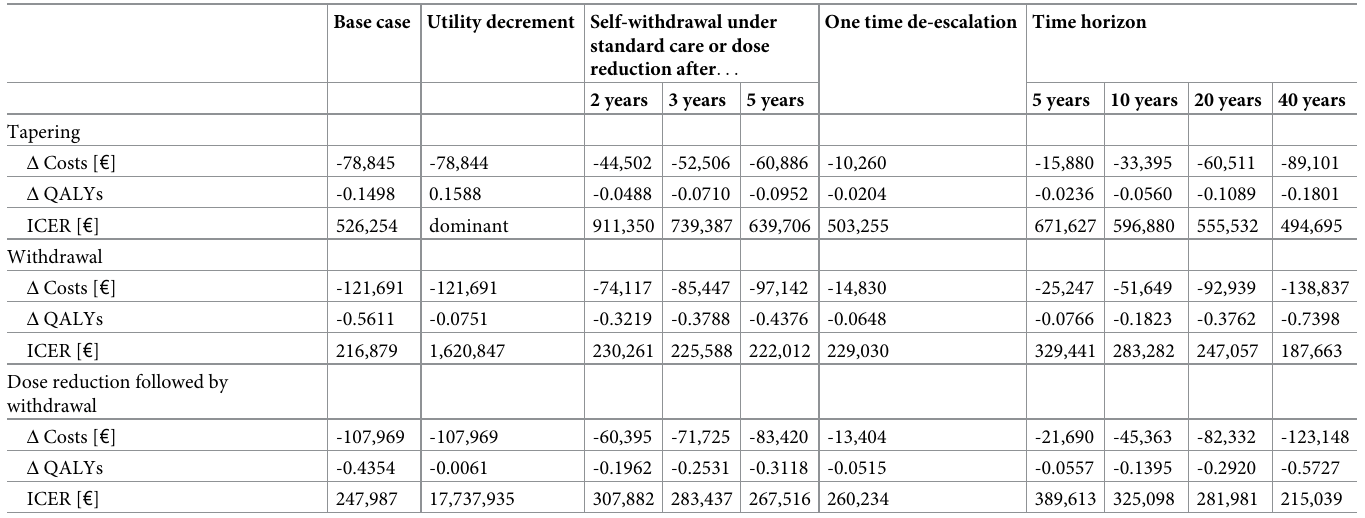
Table 3. Results from scenario and structural sensitivity